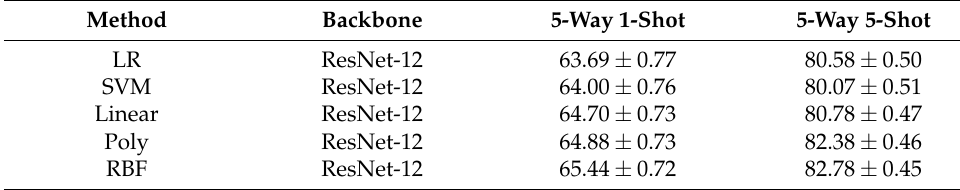
Table 8. Comparison results of different methods in the UC Merced dataset.